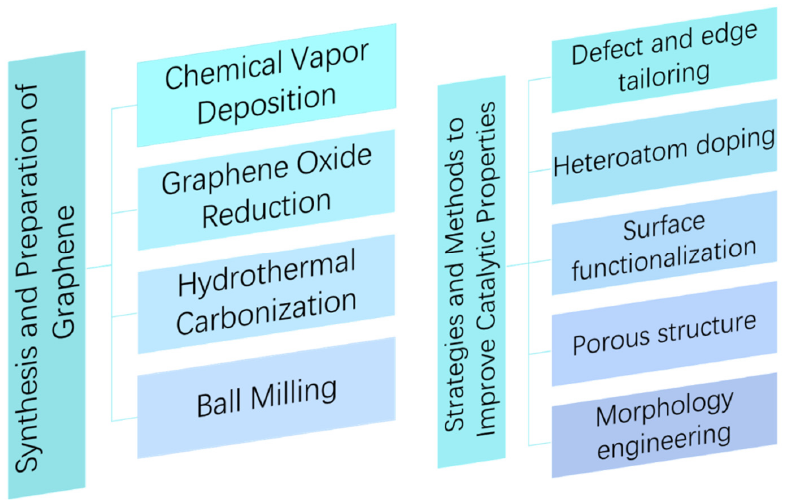
Scheme 1. Schematic diagram of graphene electrocatalysts for HER and graphene preparation method.